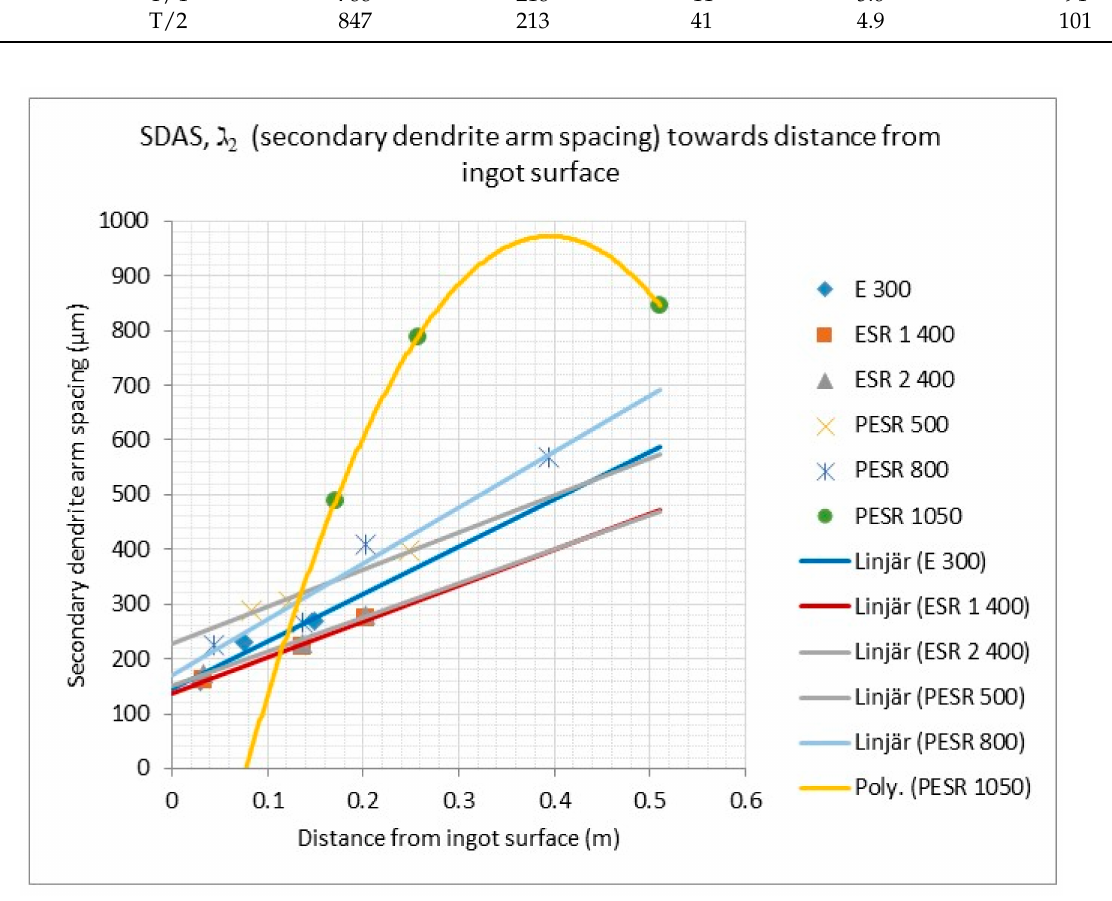
Figure 7. Secondary dendrite arm spacing, (SDAS, ג 2 ), per distance from surface for different ingot 300 × 300 mm 2 (CE-300), the electro-slag remelted ingots 400 × 400 mm 2 (ESR-400 1,2), and the pressure electro-slag remelted ingots 500–1050 mm in diameter (PESR-500, PESR-800, and